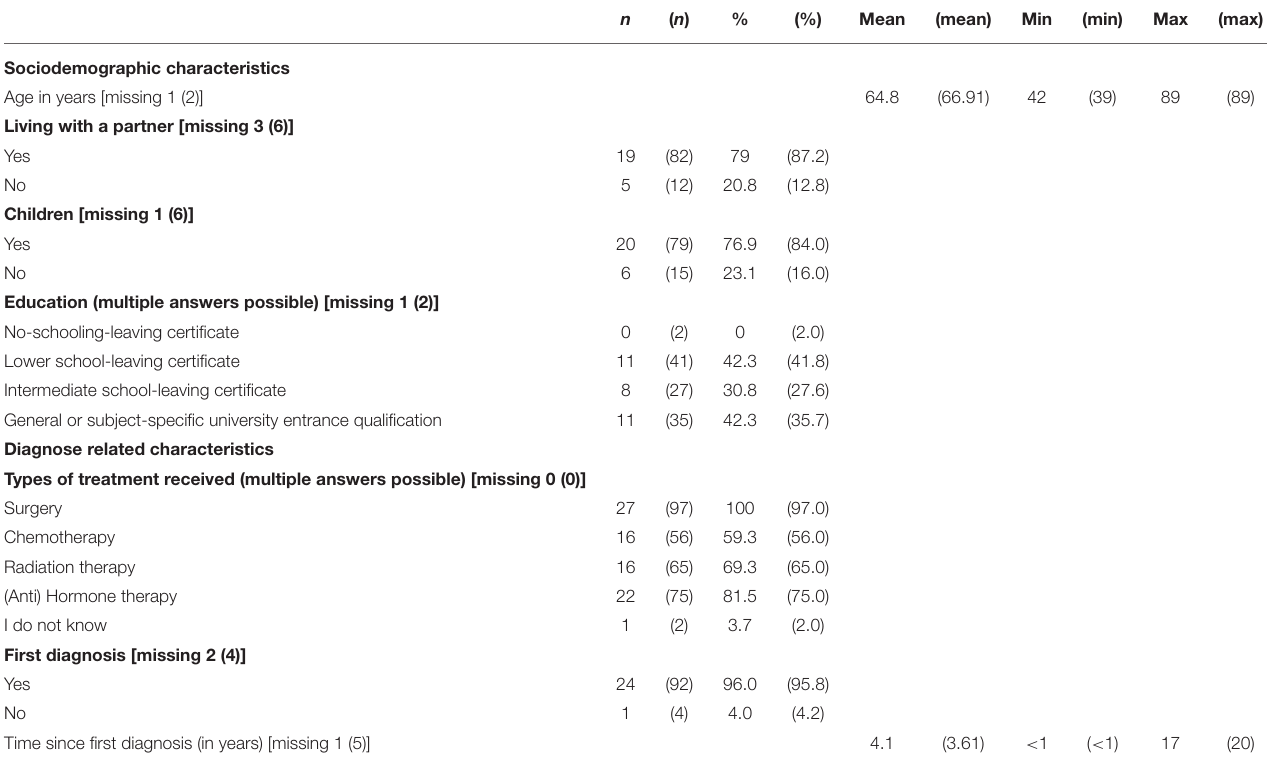
TABLE 2 | Socio-demographic and disease-related characteristics of the whole sample.